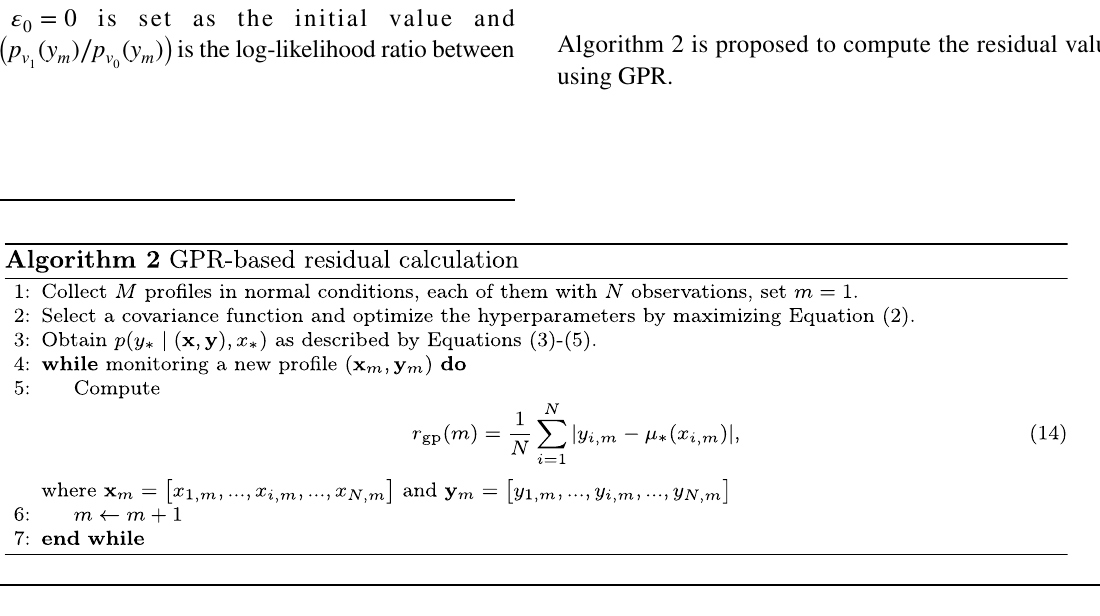
Algorithm 2 is proposed to compute the residual value r gp using